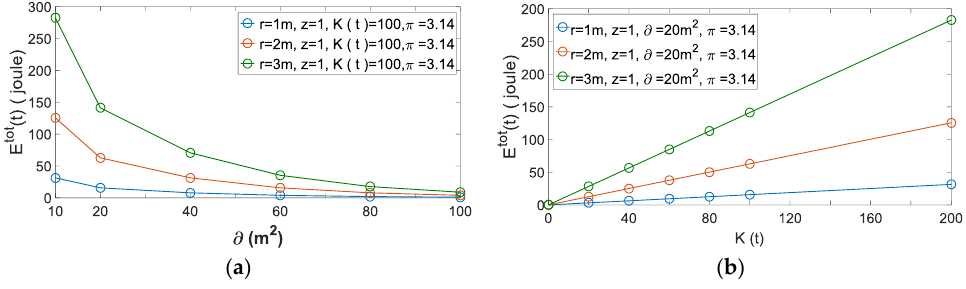
Figure 10. Representation of Equation (5): ( a ) total energy utilization via actual coverage area; ( b ) total energy utilization via number of active sensor nodes.